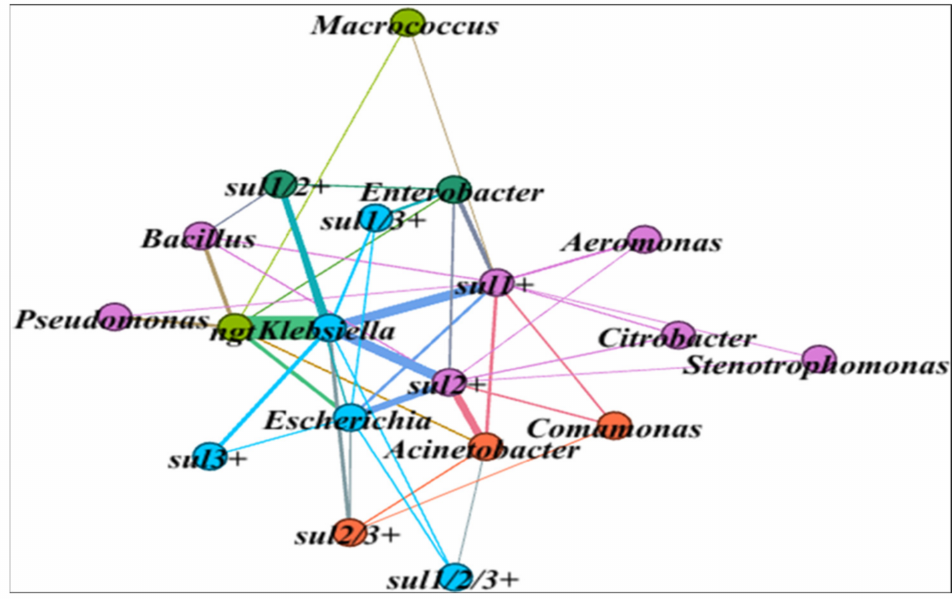
Figure 7. Identification of potential sul genes bacterial carriers by network